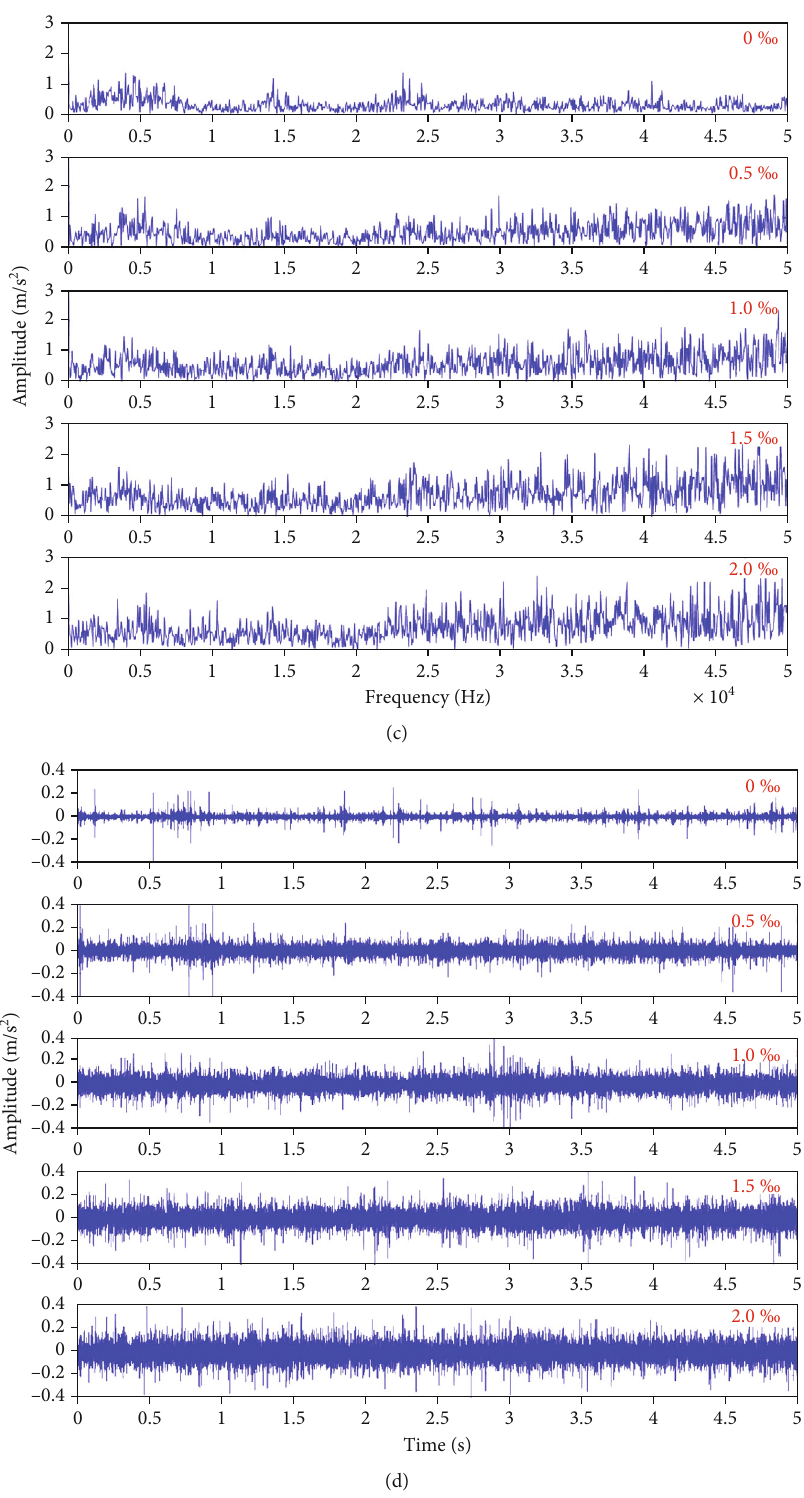
Figure 3: Characteristic analysis of the sand measurement signal under di ff erent sand content conditions (particle size 150 μ m, fl ow velocity 1.5m/s): (a) frequency domain diagram; (b) time spectrum; (c) 30-50kHz frequency domain diagram; (d) 30-50 kHz time domain